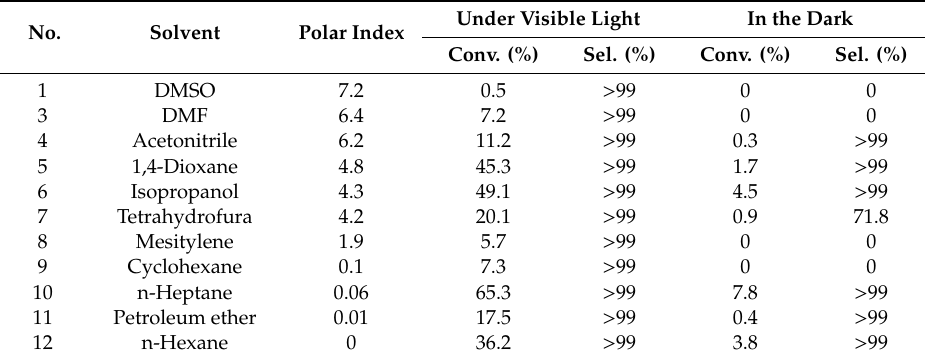
Table 4. E ff ect of di ff erent solvents on the reaction of benzyl alcohol and acetophenone. Under Visible Light In the Dark No. Solvent Polar Index Conv. (%) Sel. (%) Conv. (%) Sel. (%)